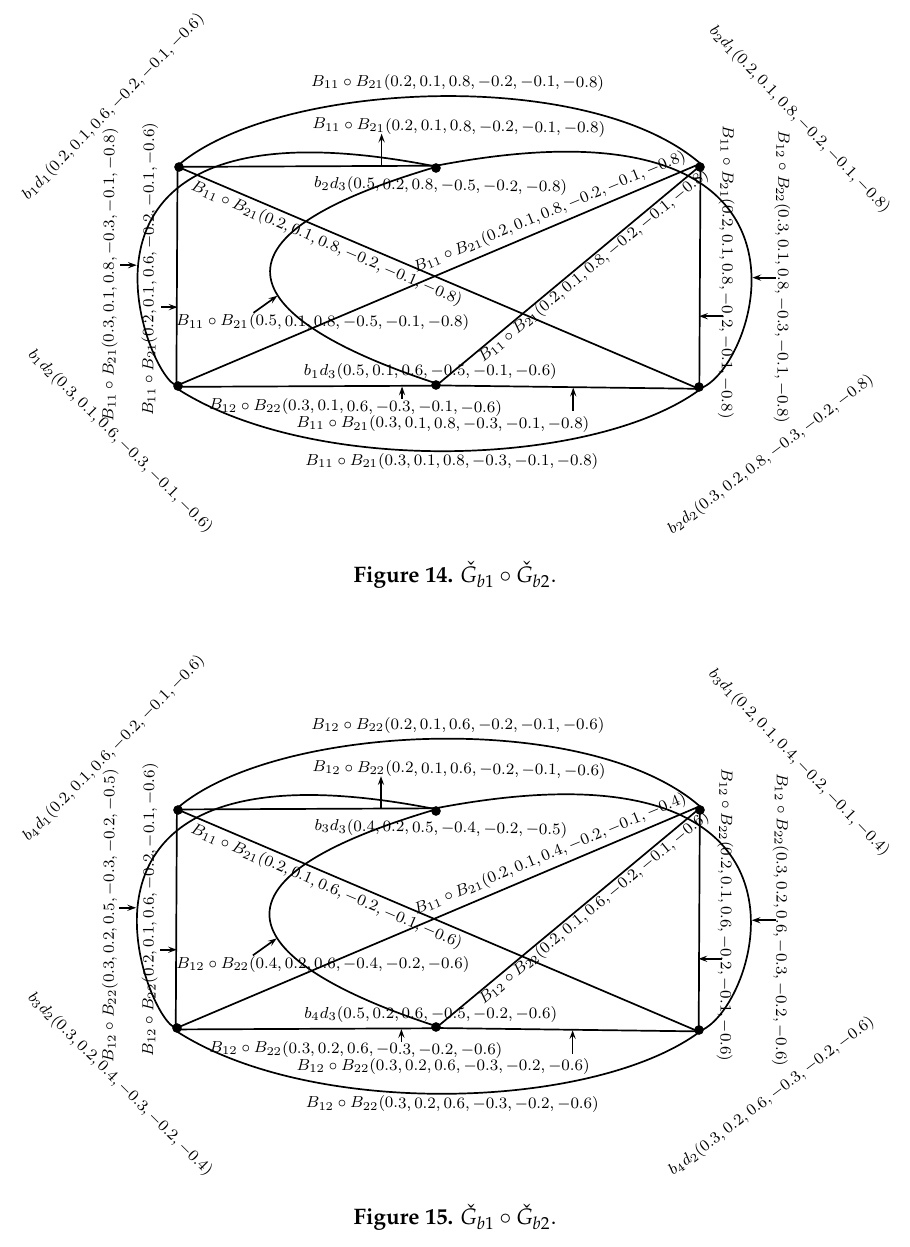
Figure 15. ˇ G b 1 ◦ ˇ G b 2 Figure 2.15: ˇ G b 1 ◦ ˇ G b 2